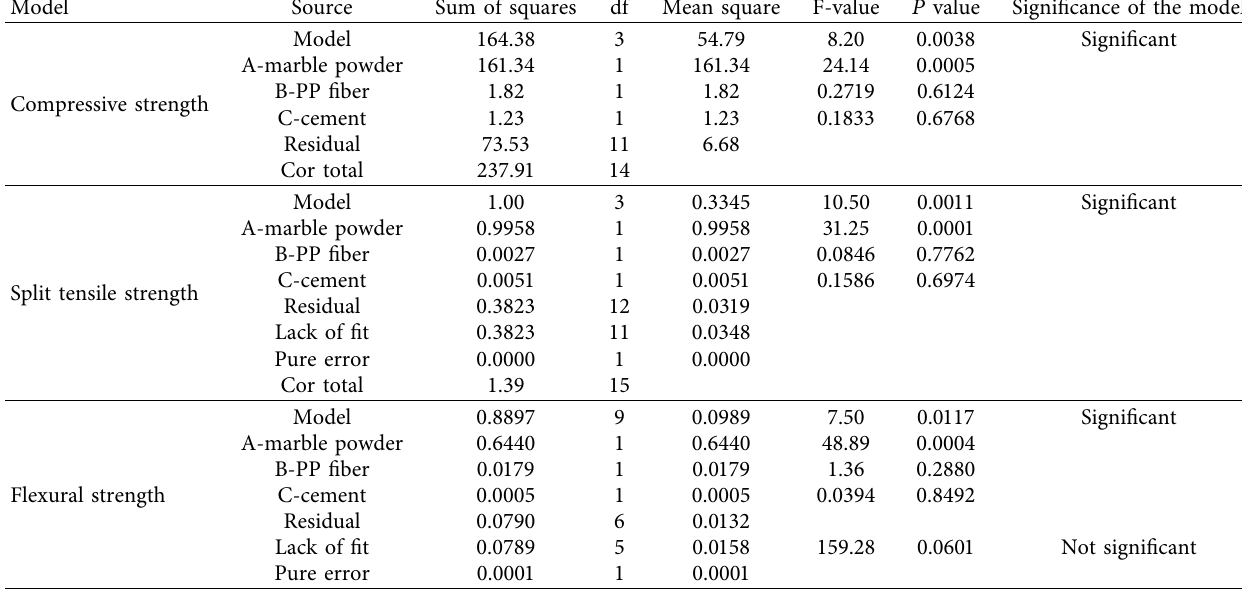
Table 5: ANOVA analysis of the response models.